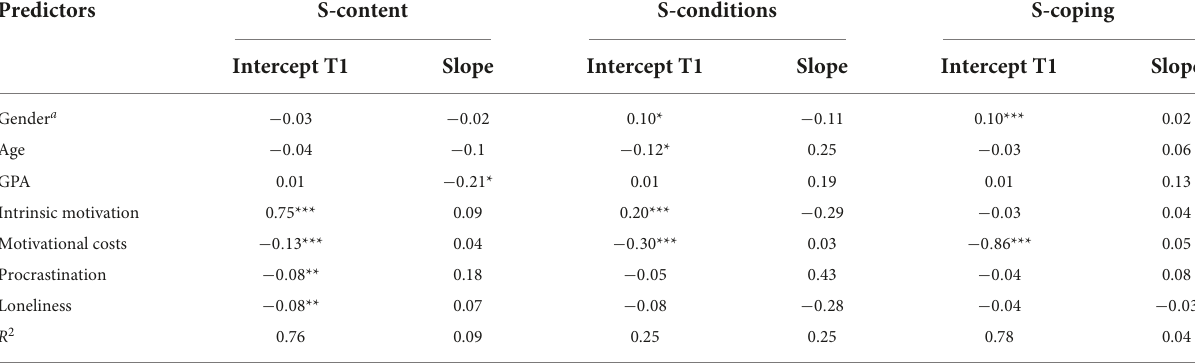
TABLE 4 Prediction of study satisfaction subdimensions at T1 and changes over time in study 1 (standardized coefficients).